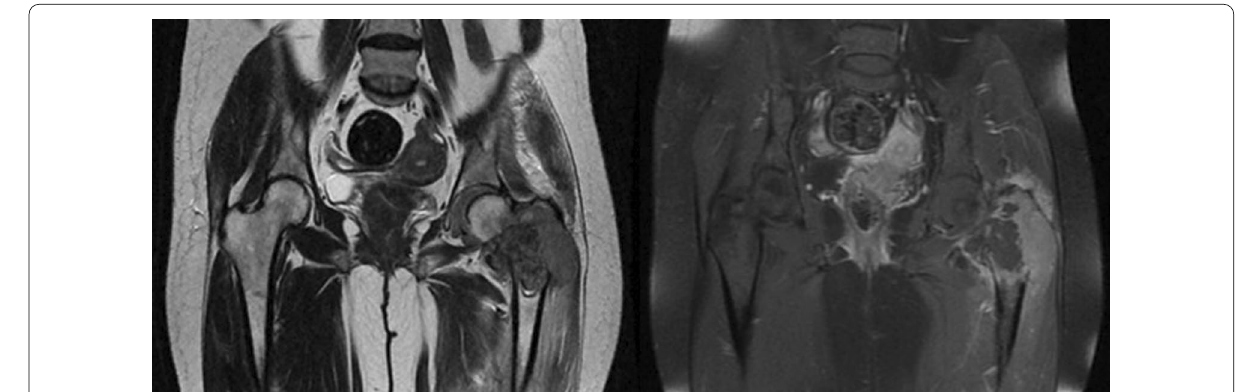
Fig. 2 Coronal T2WI showing heterogeneously hypointense lesion in metaphyseal and diaphyseal region of proximal end of left femur. Cortical break noted. Few hypointense calcific foci seen. T1 contrast shows heterogeneous +